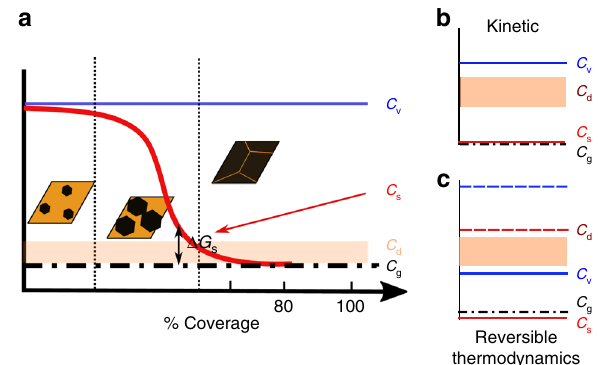
Fig. 3 Schematic of growth thermodynamics and kinetics. a Carbon potentials at various coverage levels with reference to that inside the graphene grain C g . C d , C s , and C v represent defect (at grain boundary), surface and vapor phase potentials. b Energetic situation in which the lack of grain boundary closure will be termed kinetic. Vapor carbon